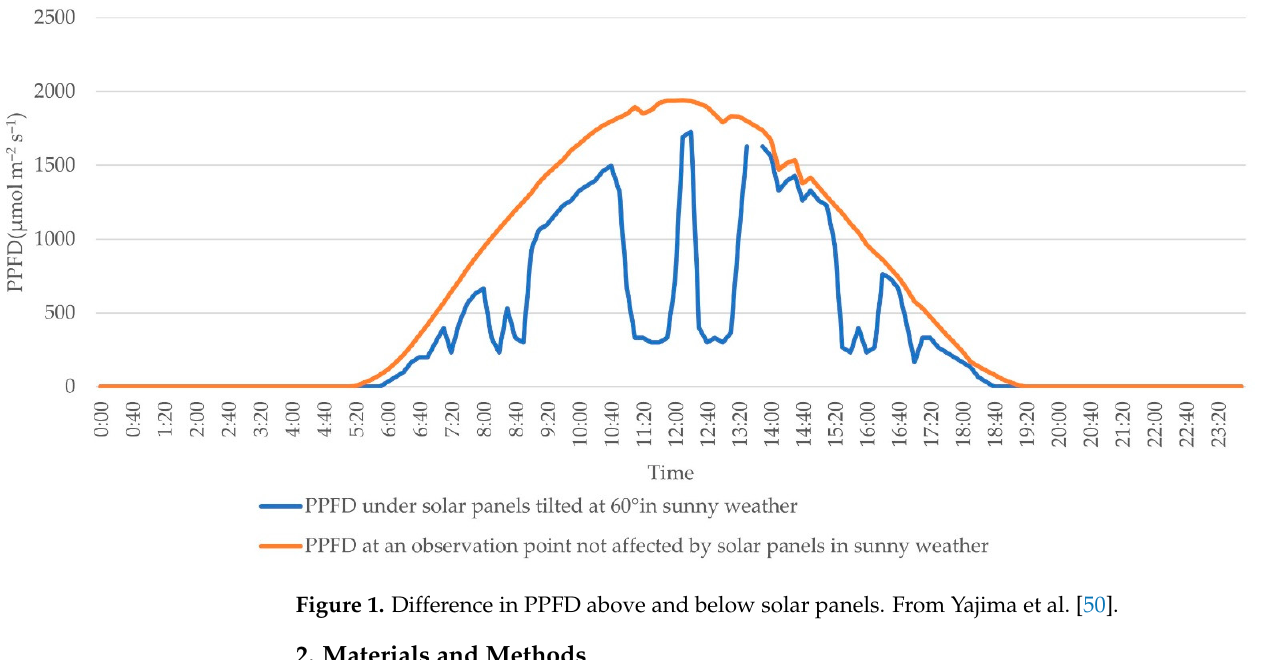
Figure 1. Difference in PPFD above and below solar panels. From Yajima et al. [50].